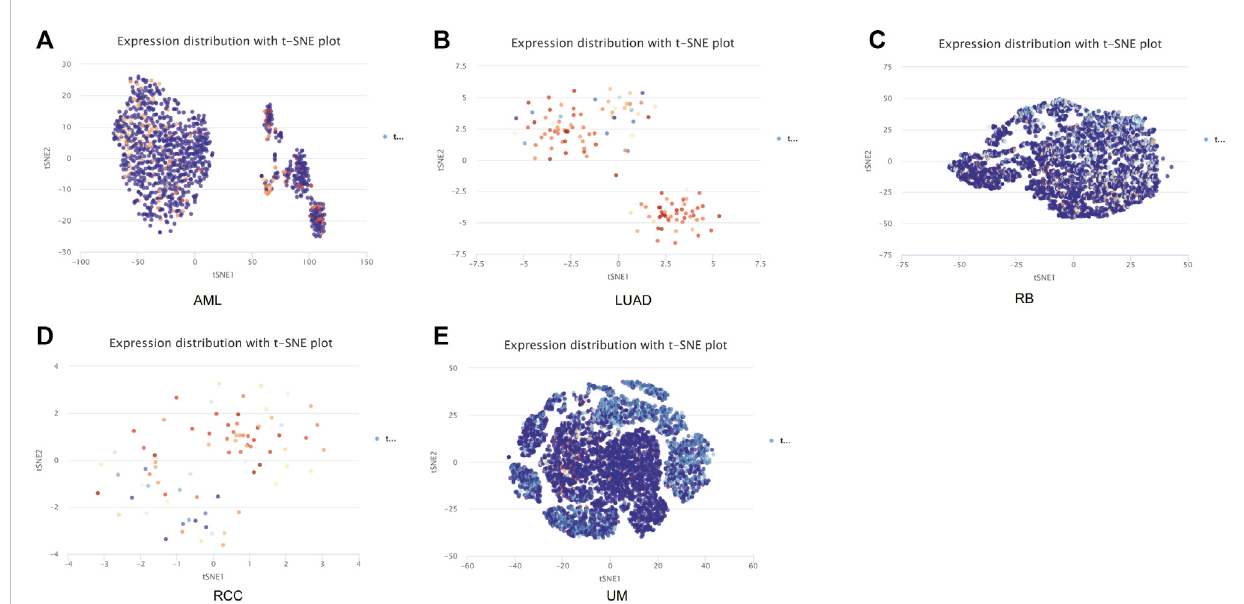
FIGURE 11 ThedistributionofDLDexpressionatthesingle-celllevelintheabove fi vetumorsisdemonstratedint-SNEplots. (A) AML. (B) LUAD. (C) RB. (D) RCC. (E)